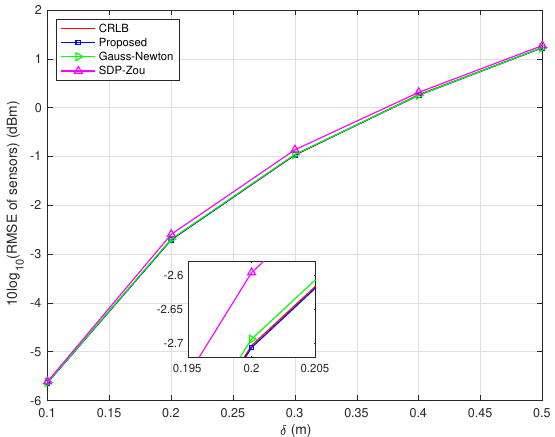
Figure 3. RMSE of sensors vs. δ with σ = 0.1 m in scenario